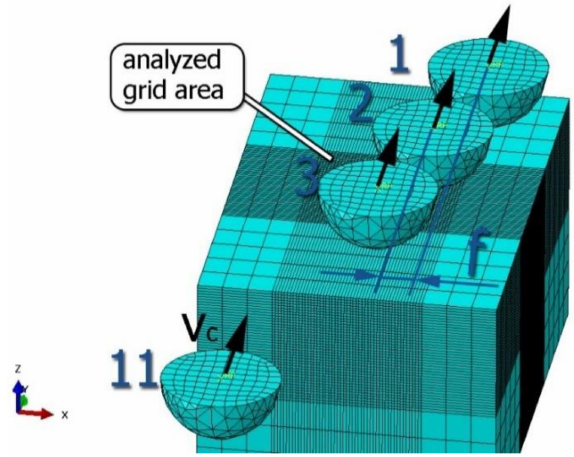
Figure 3. FEM simulation of the slide burnishing